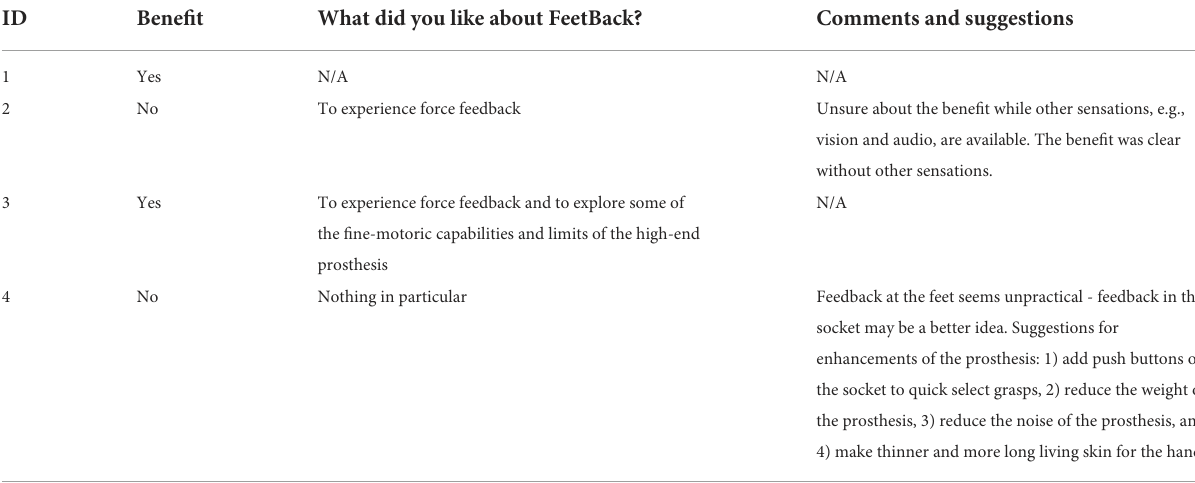
TABLE 3 The participants’ answers to the post-study